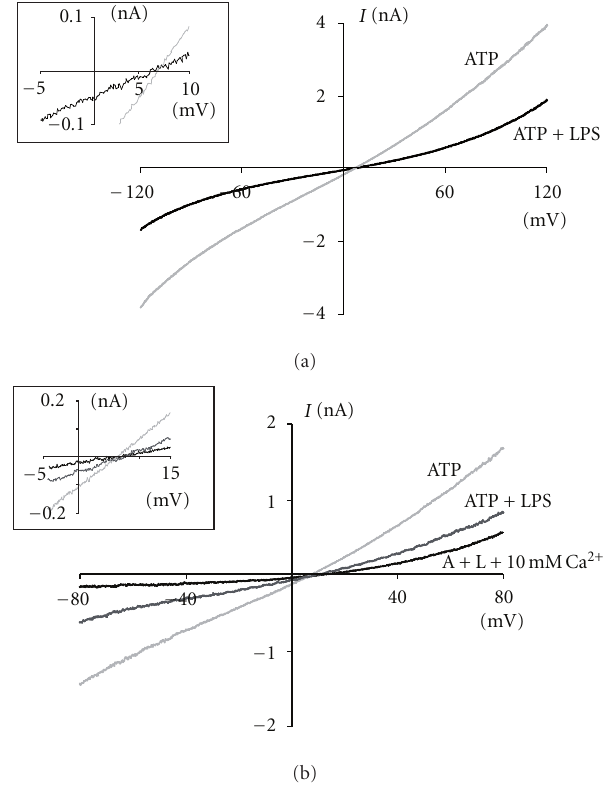
Figure 2: LPS does not change the permeability of the P2X7R. (a) Voltage-ramp protocols were applied with 300 μ M ATP alone (grey line) or treated with 1 μ g/mL LPS (black line); the insert shows a closeup of reversal potentials. Control and treated experiments were performed in parallel and repeated independently 4